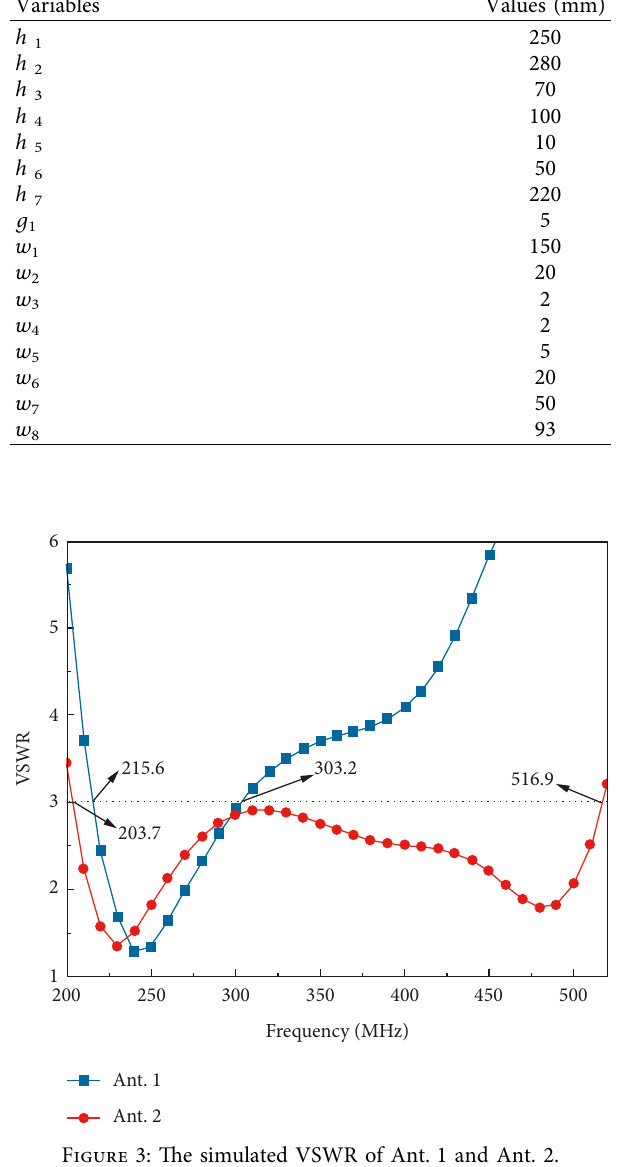
Table 1: The values of the variables of the monopole antenna. Variables